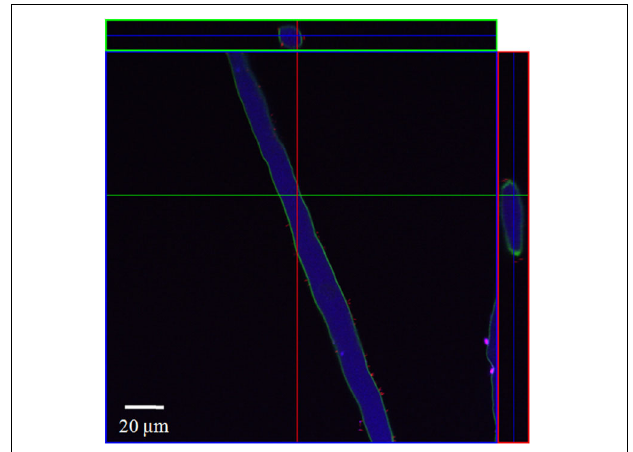
FIGURE 1 | CLSM image of a spinach root hair. The plant seedling was inoculated for 1h with S. enterica sv. Weltevreden at an inoculation density of 4 × 10 6 CFU/ml. The plant was harvested after 3 weeks of growth in an axenic system. Probe Cy3 marked EUB-338, I, II, III was applied during FISH procedure (red signal).